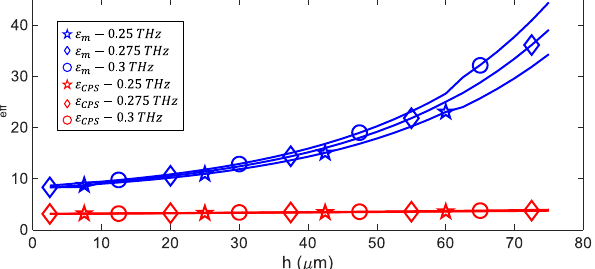
Figure 5. The comparison of the proposed effective dielectric constant model ( ε m at 0.25 THz, 0.275 THz and 0.3 THz) with the CPS approximation ( ε CPS at 0.25 THz, 0.275 THz and 0.3 THz): proposed model ( h = 2.5-to-